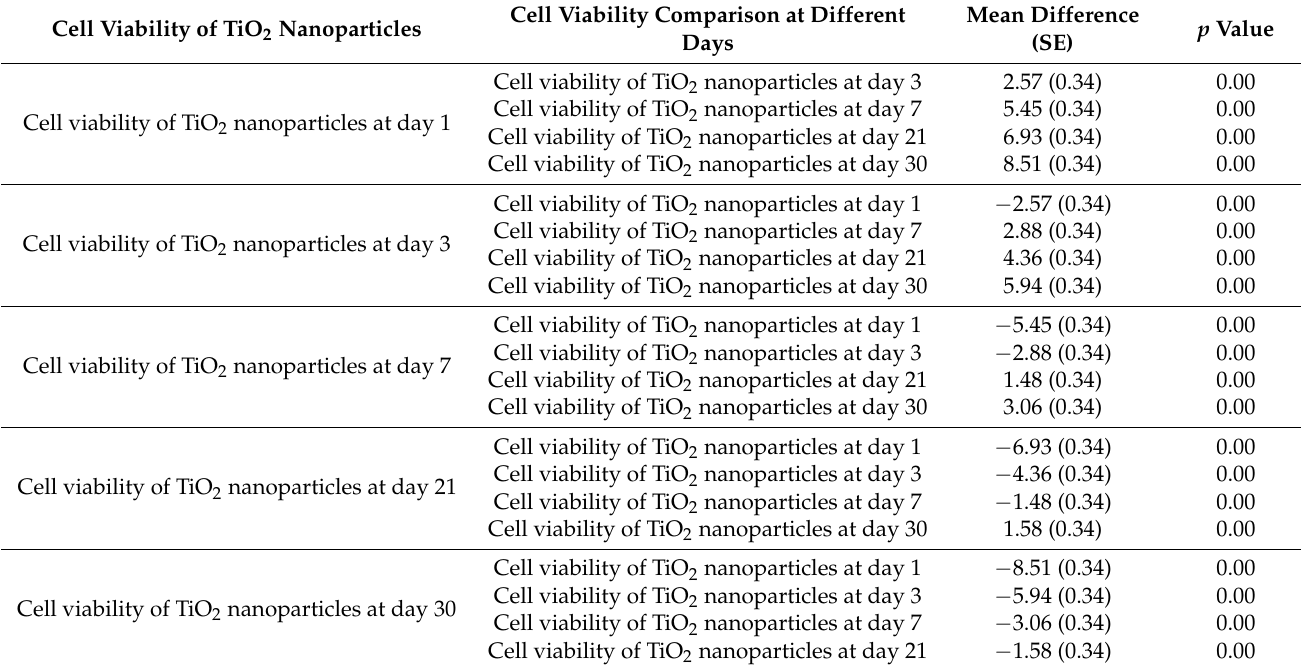
Table 2. Inter-group comparison of cytotoxicity analysis of TiO 2 nanoparticles synthesized by Bacillus subtilis across days 1, 3, 7, 21 and